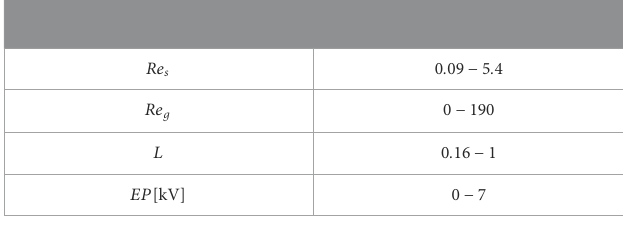
TABLE 1 Ranges of dimensionless numbers and electric